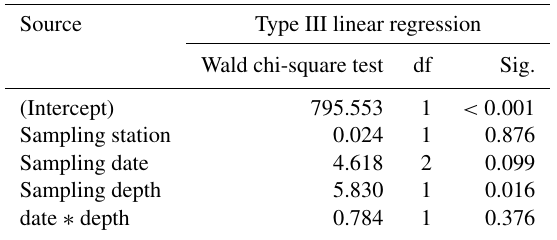
Table 4. Results of the generalized linear model (link function: identity, normal distribution) approach to analyze the statistical sig- nificance of AD changes of Trilobatus sacculifer with a sac-like chamber ( n = 27) as a function of station (replicate), sampling date, sampling depth, and the interaction between sampling date and sam- pling